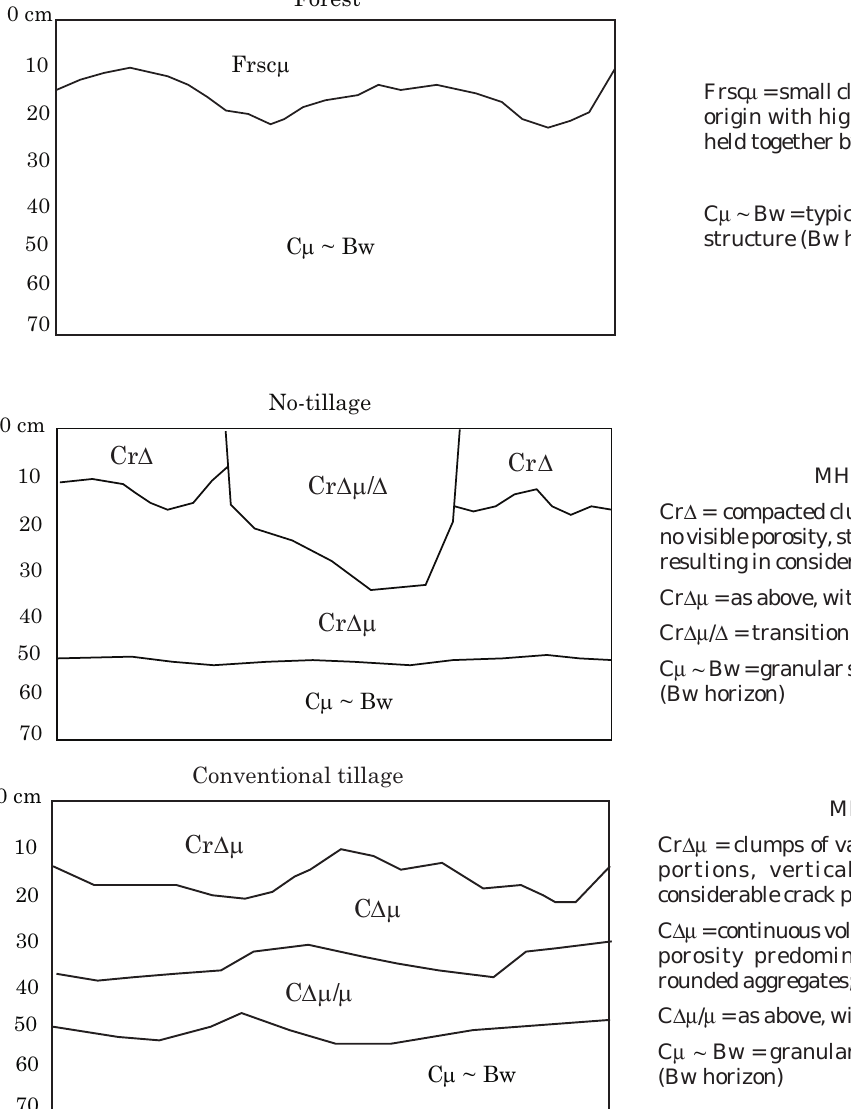
Figure 1. Diagrammatic representation of morphologically homogeneous anthropic layers (MHAL) under forest (a), no-tillage (b) ande conventional tillage